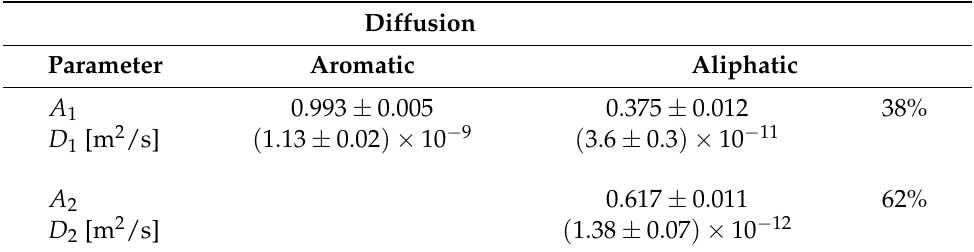
Table 2. Fit parameters used to fit the in Figure 16 shown PGSTE signal decays of aromatic and aliphatic protons in a solution of 150g/L asphaltene in benzene-d 6 , using Equation